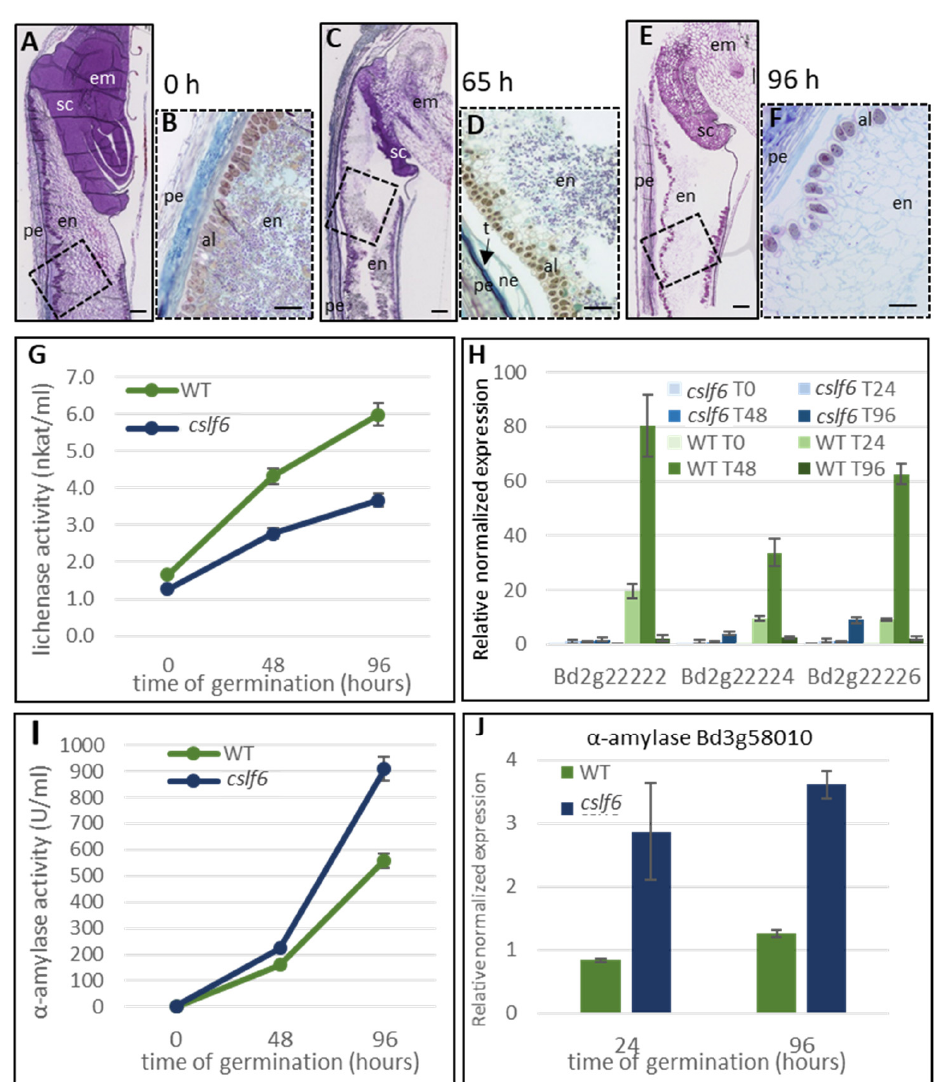
Figure 10. Catabolism of reserve sugars in homozygous cslf6 mutant. ( A – F ): Histology of cslf6 grains at 0 h (images ( A , B )), 65 h (images ( C , D )), and 96 h (images ( E , F )) of germination. ( A , C , E ): Images of longitudinal grain cross-sections stained with toluidine blue. ( B , D , F ): Higher magnification images of the sections corresponding to the dotted boxes on the images ( A , C , E ), respectively, and stained with both Toluidine blue and iodine. Starch granules are coloured purple by iodine. Scale bar = 100 µ m. en: endosperm; al: aleurone; pe: pericarp; t: testa; ne: nucellar epidermis; em: embryo; sc: scutellum. ( G ): Lichenase activity from wild type and cslf6 germinated seeds. ( H ): Transcript levels of Bradi2g22222, Bradi2g22224, and Bradi2g22226 genes in WT and cslf6 grains at 0, 24, 48, and 96 h of germination. ( I ): α -amylase activity in WT and cslf6 mutant grains at 0, 48, and 96 h of germination. ( J ): α -amylase transcript level in WT and cslf6 mutant grains at 24 and 96 h of germination. Error bars represent standard deviation of the mean ( n =